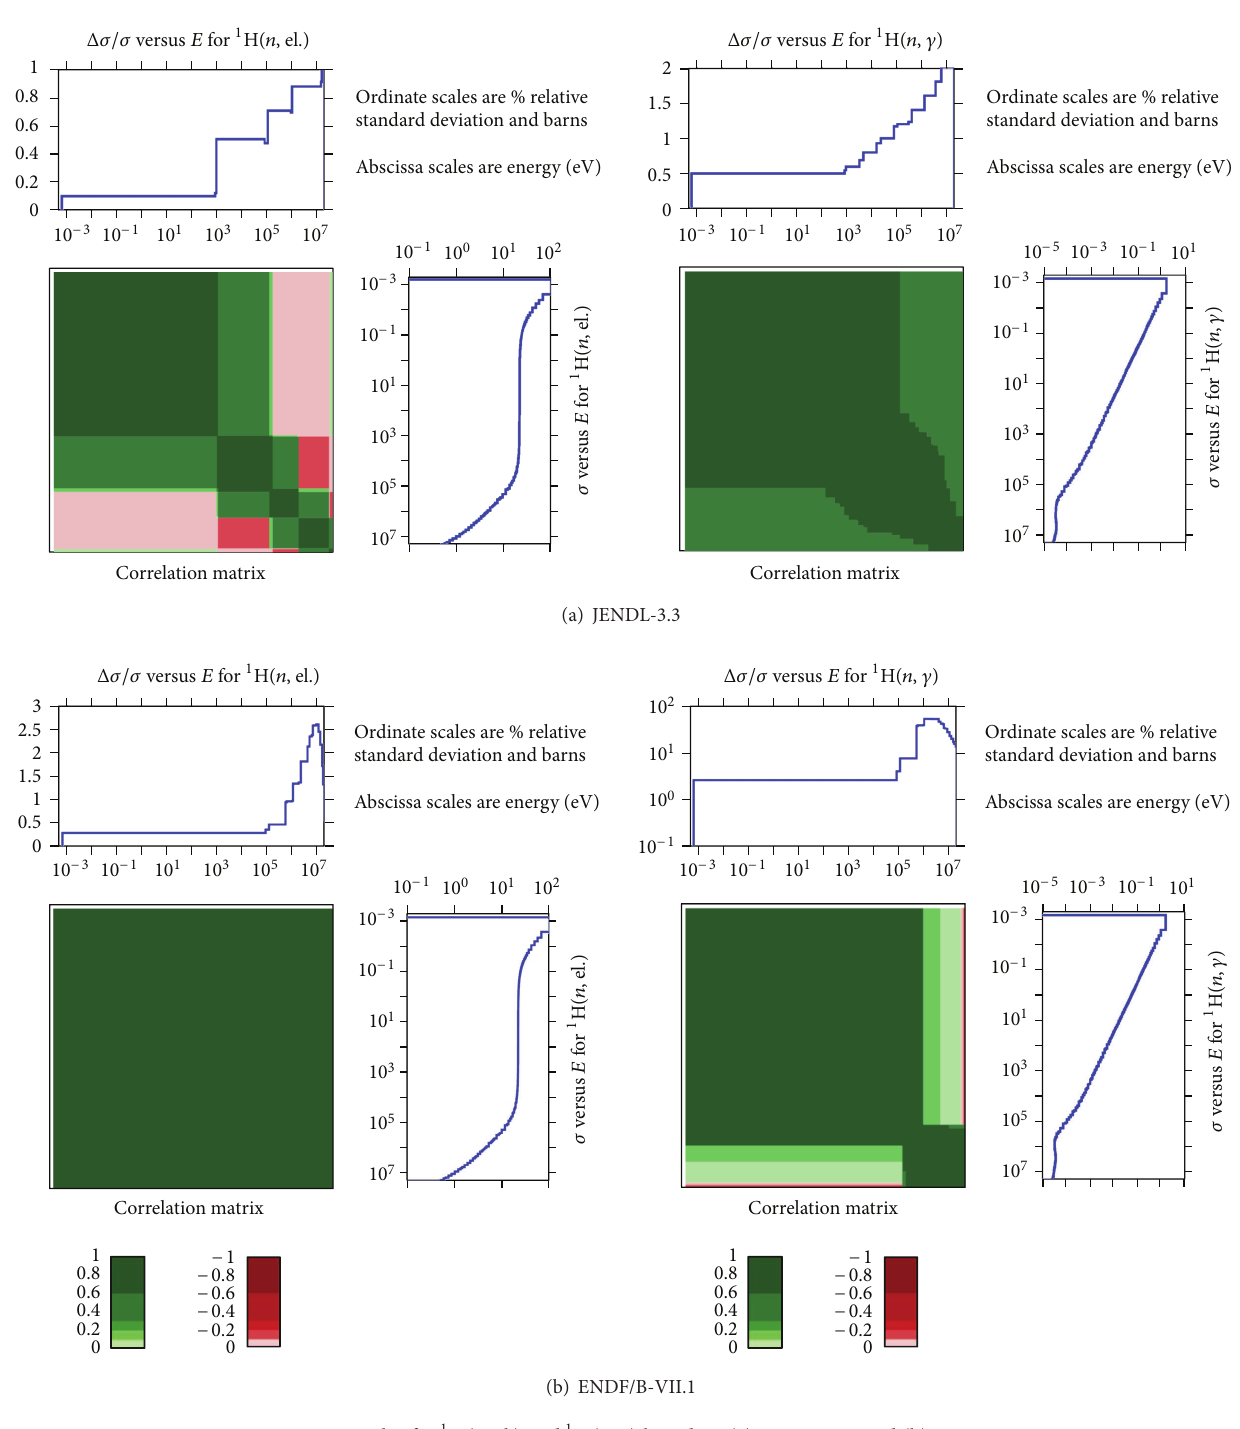
F 1: Covariance plot for